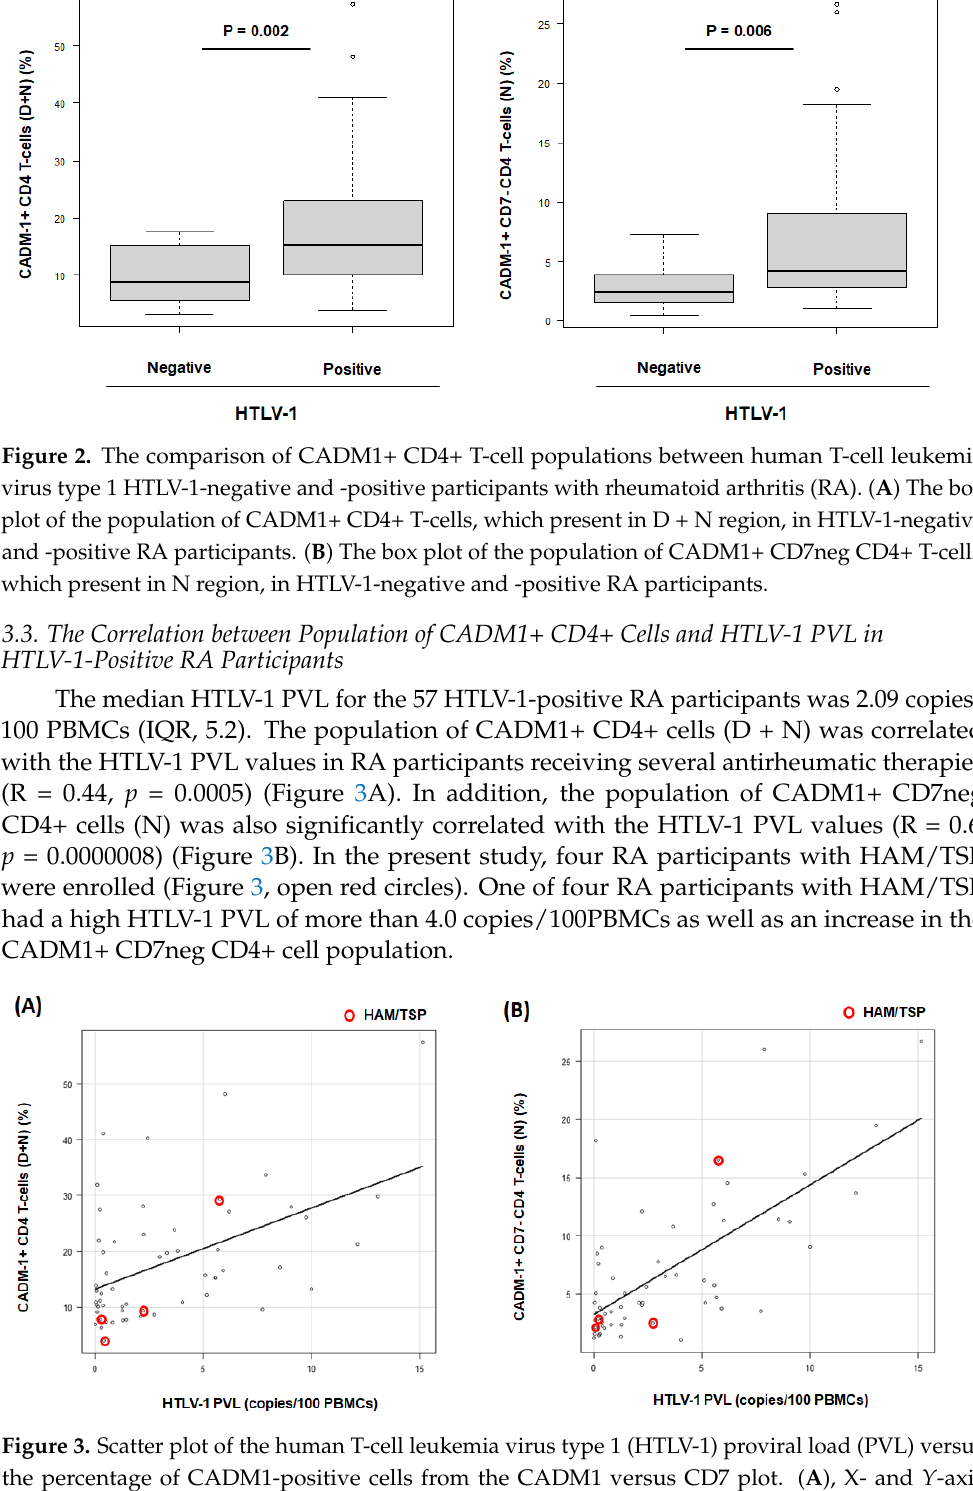
CADM1 versus CD7 plot of CD4+ T-cell population. Upper-right and lower-right regions were named D and N, following previous study. The CD4+ T-cells in D and N region are human T-cell (PVLs). The HTLV-1 PVL were 5.66 and 15.1 copies/100 peripheral blood mononuclear cells, respec- tively.